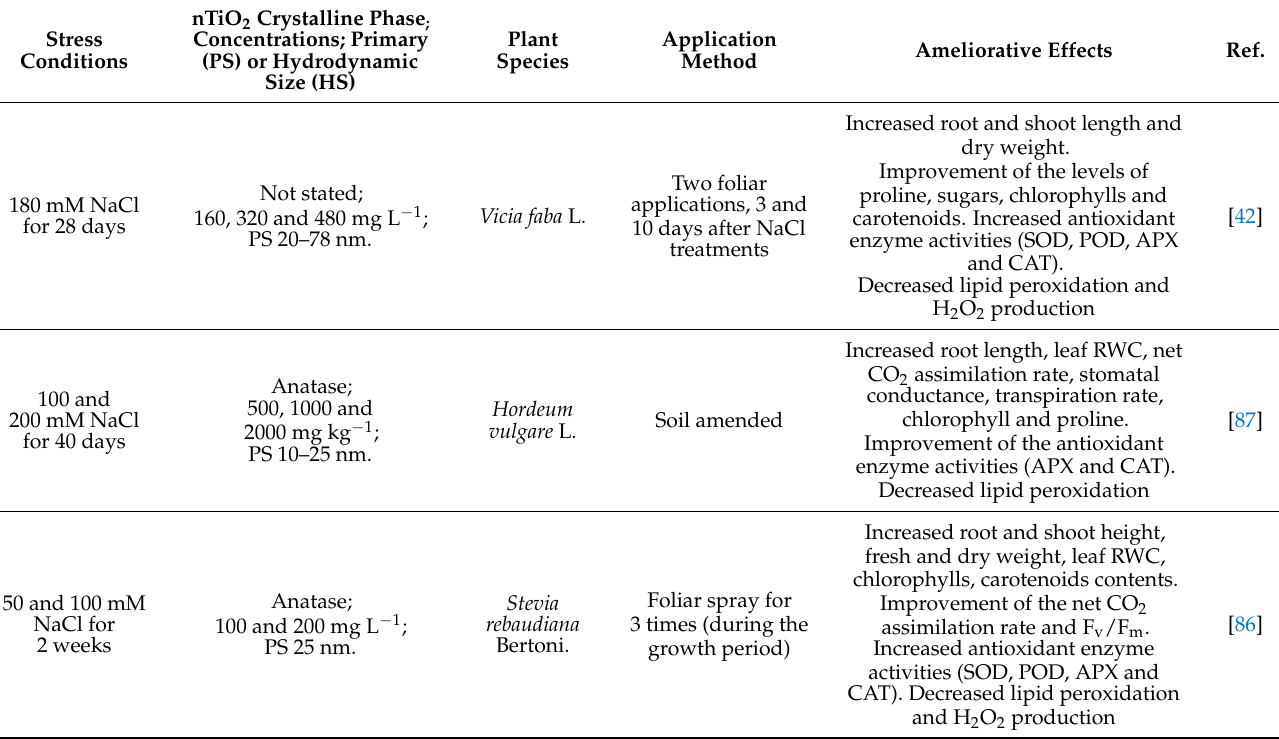
Table 2. Effects of nTiO 2 on plants under salinity